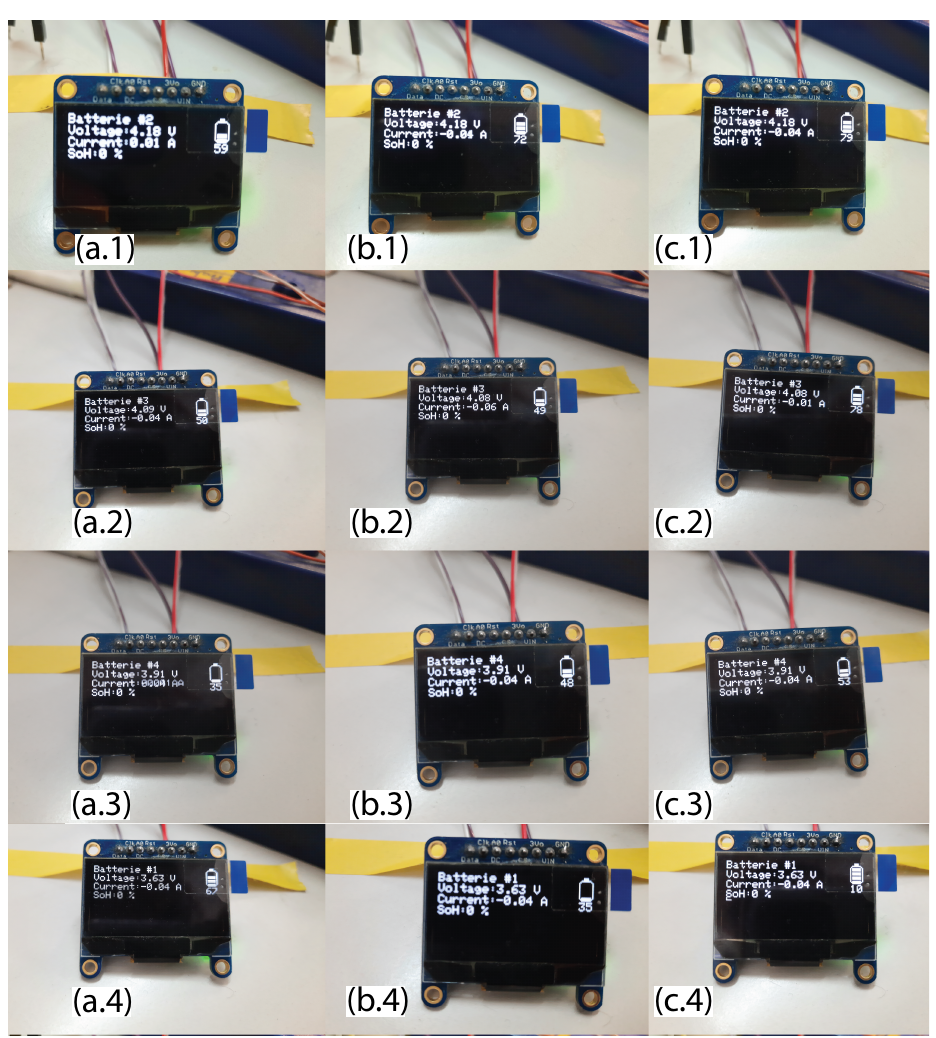
Figure 12. On-mode display of cells 1, 2, 3 and 4 with a real SOC value of 77.25%, 71.10%, 55.02% and 9.51% respectively: ( a.1 – a.4 ) Average SOC of the first 50 iteration. ( b.1 – b.4 ) A few seconds after. ( c.1 – c.4 ) approximately 1 min after